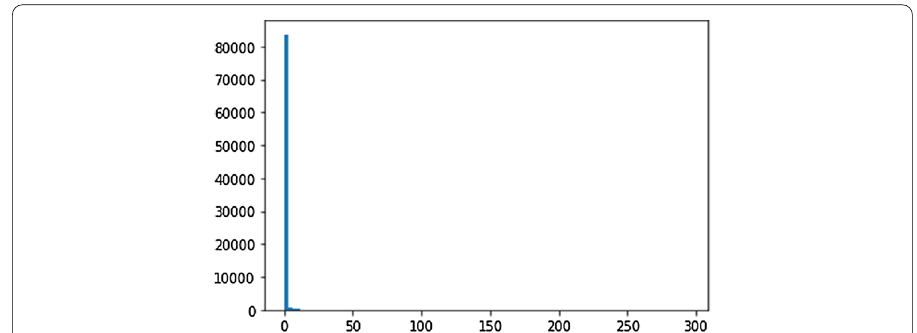
Fig. 3 Autoencoder—Number of instances vs reconstruction error value for clean data points